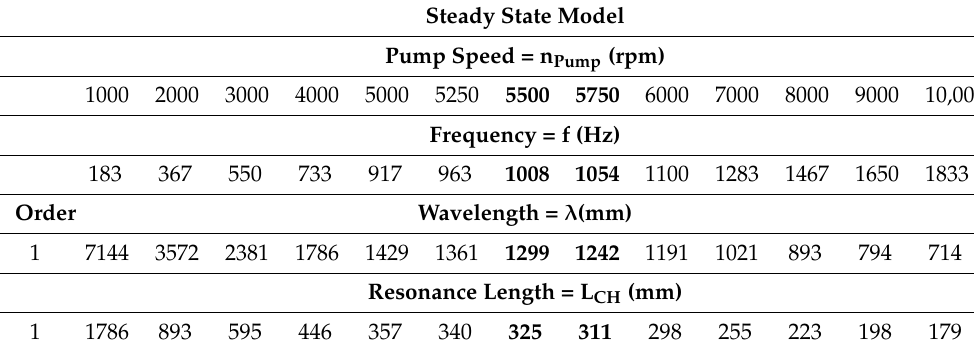
Table 5. Steady state algorithm